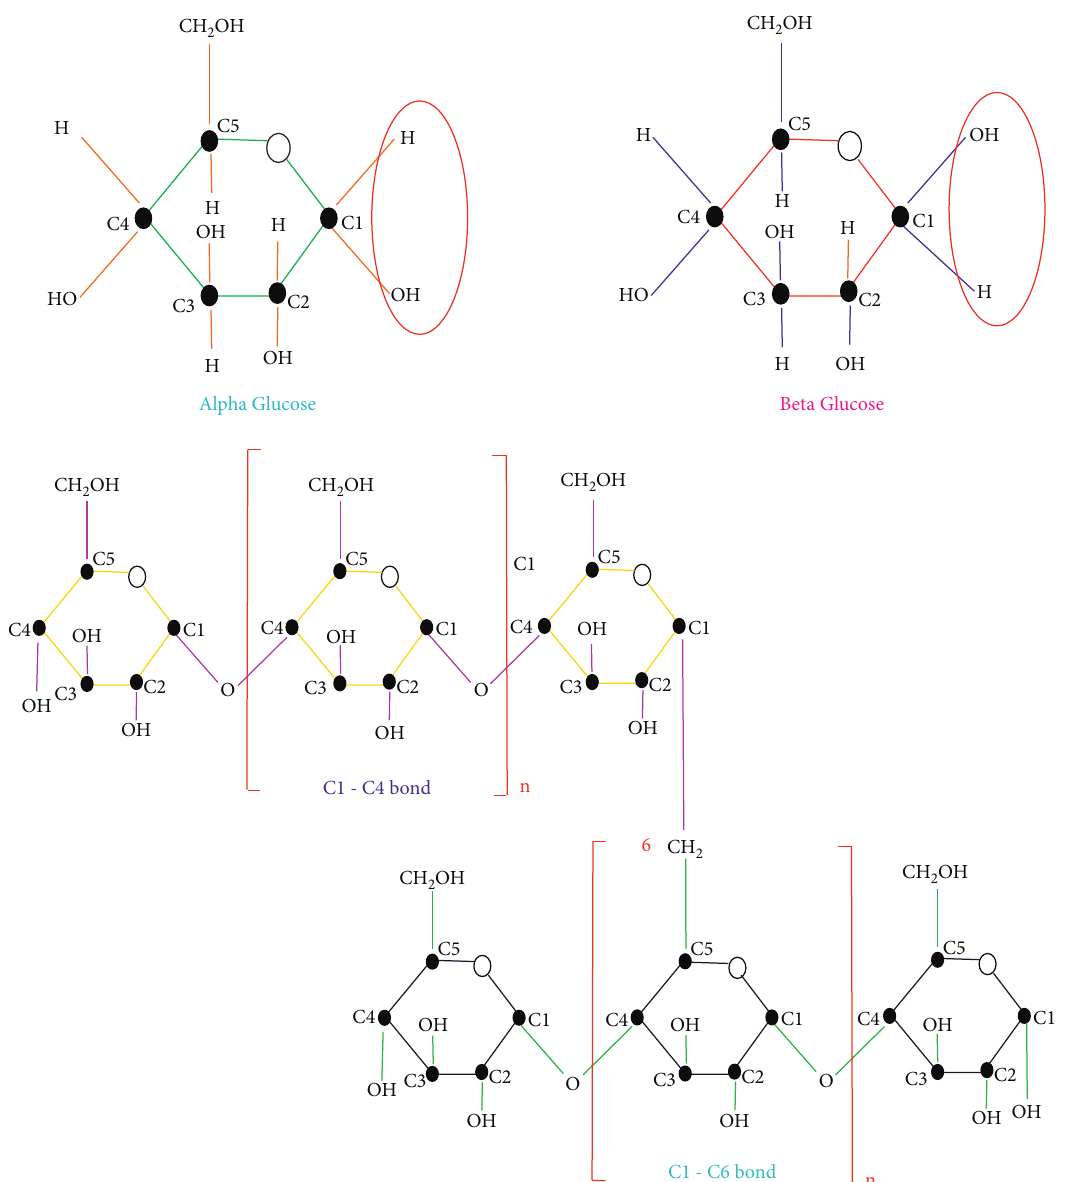
Figure 2: Basic units, α - and β -glucose, and their